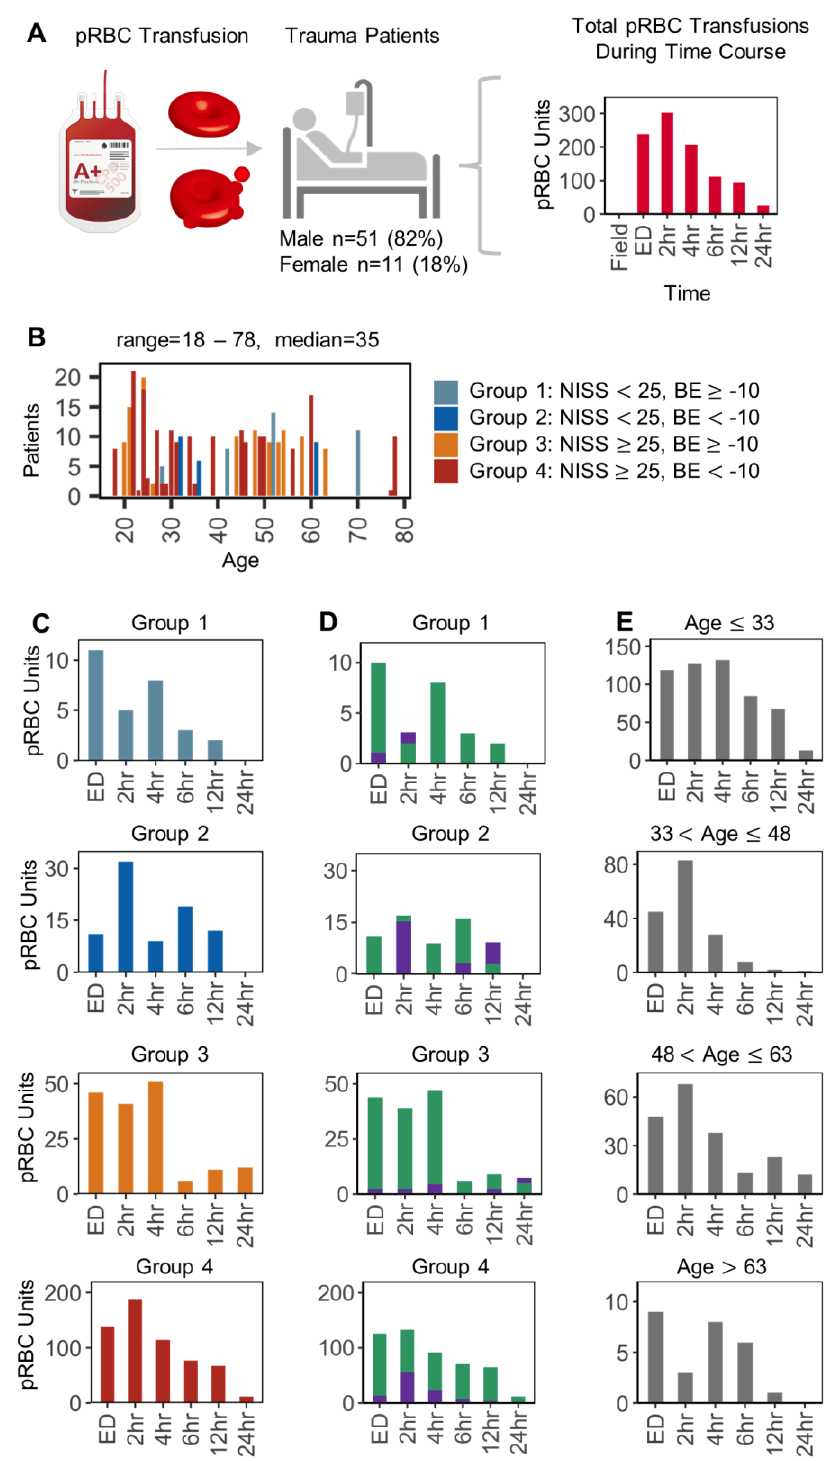
Figure 1. Overview of RBC transfusions in the COMBAT patient cohort. In ( A ), an overview of the experimental design and time distribution of pRBC transfusion events. In ( B ), subject age distribution of pRBC transfusion upon identification of four groups based on new injury severity score (NISS) and base excess (BE). Bar colors differentiated severity phenotype with light blue: Group 1 (n = 10), dark blue: Group 2 (n = 8), orange: Group 3 (n = 16), red: Group 4 (n = 27). The number of pRBC units transfused from ED-24 h were plotted independently by severity phenotype ( C ), sex ( D ): male (green, n = 50) and female (purple, n = 11), or by age ( E